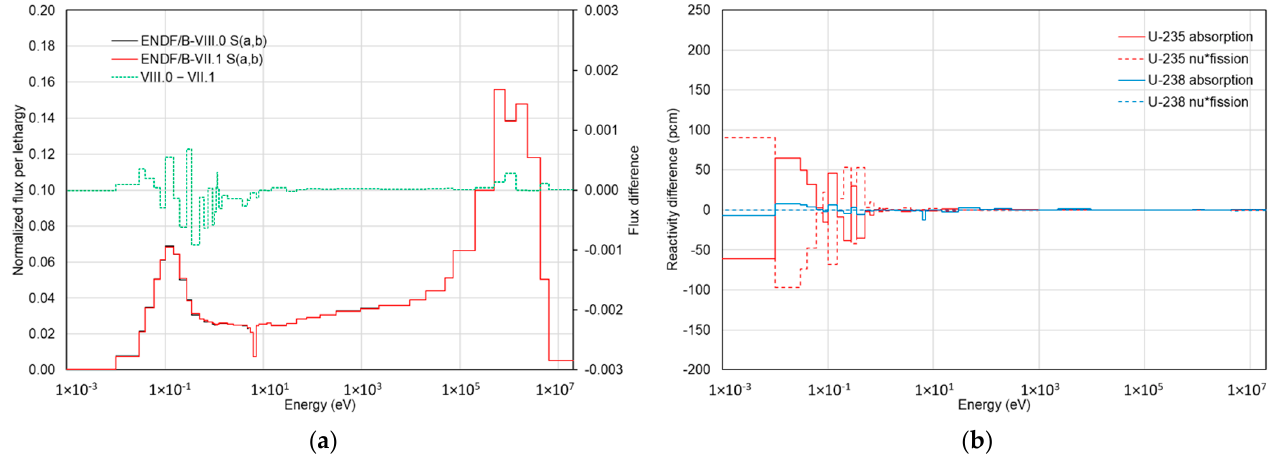
Figure 12. Comparison of the flux and reactivity between the ENDF/B-VIII.0 and VII.1 1 H S ( a , b ) thermal scattering data in the 51-group structure: ( a ) neutron spectra; ( b ) reactivity differences.